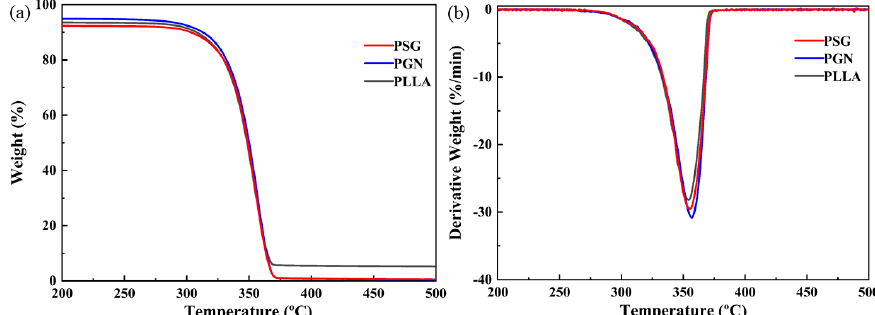
Figure 7. ( a ) TGA and ( b ) DTA curves for neat PLLA, PSG and PGN nanocomposite. Table 2. Thermal data derived from the TGA curves and DTA curves of neat PLLA, PSG and PGN nanocomposites.